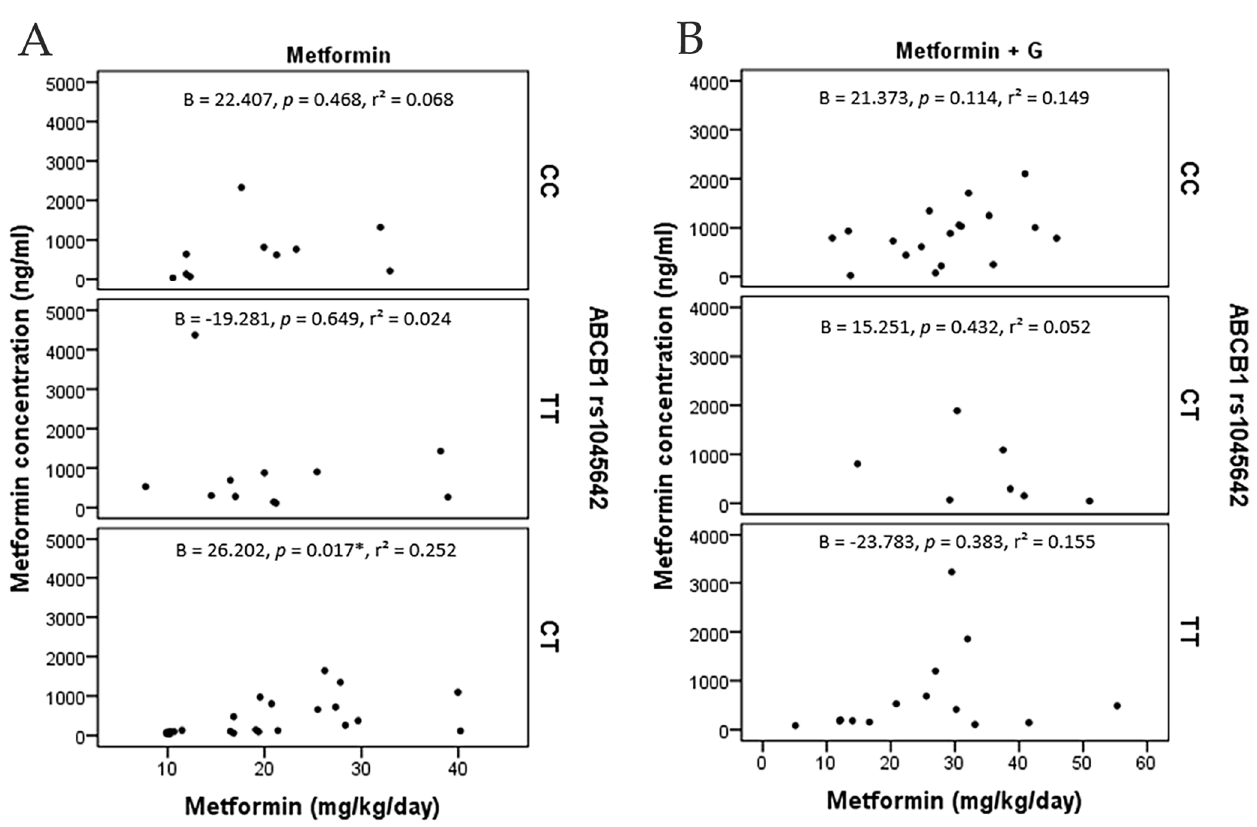
Figure 4. Metformin concentration points (ng/ml) and metformin dosage (mg/Kg/day), including angular regression coefficient with p value and determination coefficient. ( A ) metformin monotherapy patients grouped by ABCB1 (rs1045642). ( B ) metformin+glibenclamide patients grouped by ABCB1 (rs1045642). C/T presents a positive correlation among metformin monotherapy (*: p =